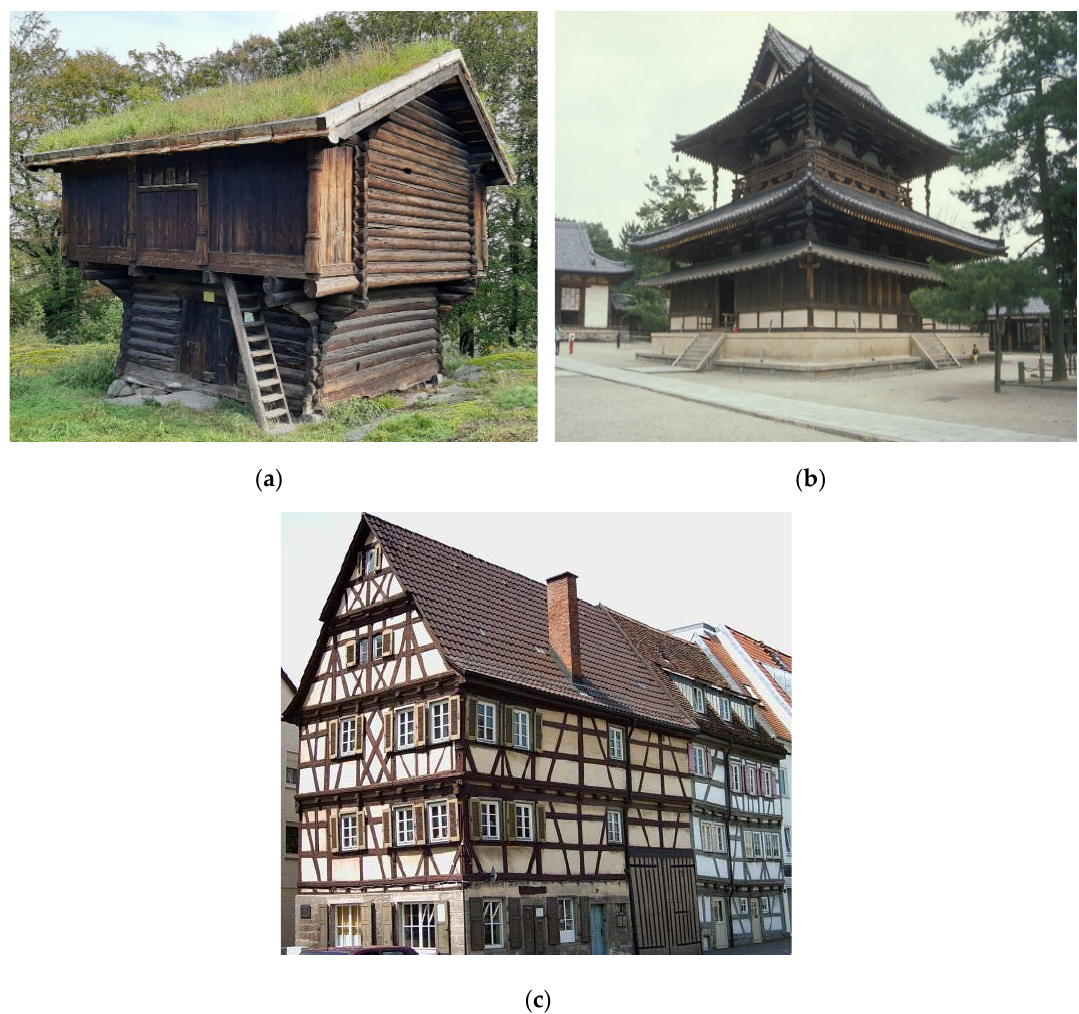
Figure 3. ( a ) Log house (Heierstad Loft, Tønsberg, Norway); ( b ) Post and beam (The Golden Hall (Kondo) of the Horyu-ji Buddhist temple, Nara, Japan) reprinted from [4]; ( c ) Timber frame building (Baden-Württemberg, Germany) reprinted from [19].